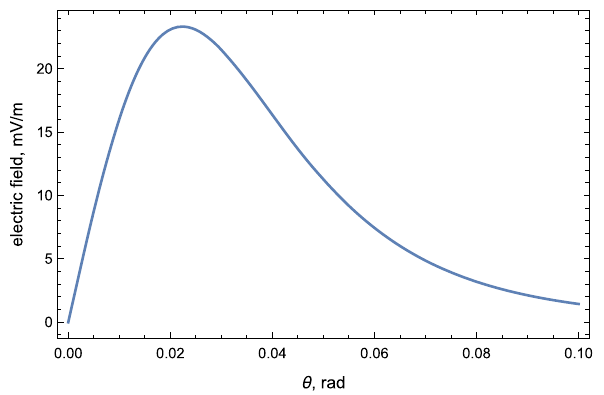
Fig. 3 Spectrum (17) in terms of frequency ν , thunderstorm